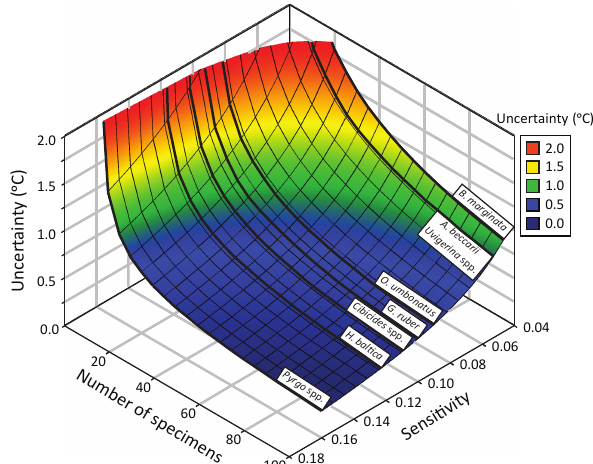
Fig. 6. Relation between sensitivity of a temperature calibration, the number of specimens analyzed and uncertainty in tempera- ture based on an average standard deviation in a population of foraminifera of 16.3% of the